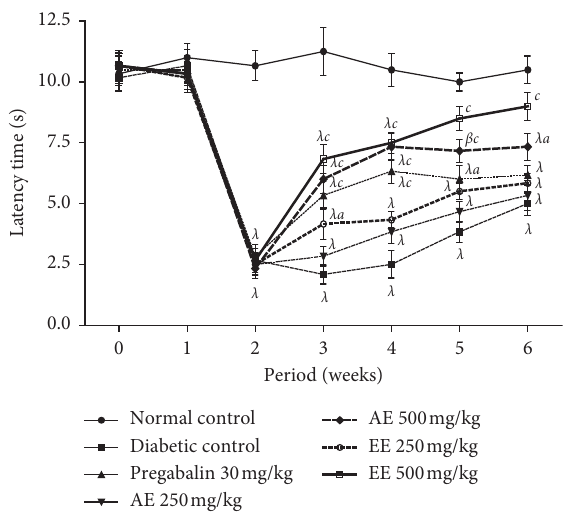
Figure 3: Effects of the aqueous (AE) and ethanol (EE) extracts of Dissotis thollonii on thermal hyperalgesia induced by hot plate. Values are expressed as mean ± SEM for six animals and analyzed by two-way ANOVA followed by Bonferroni post hoc test. β p < 0 . 01, λ p < 0 . 001 when compared with the normal control and a p < 0 . 05, c p < 0 . 001 when compared with the diabetic control.